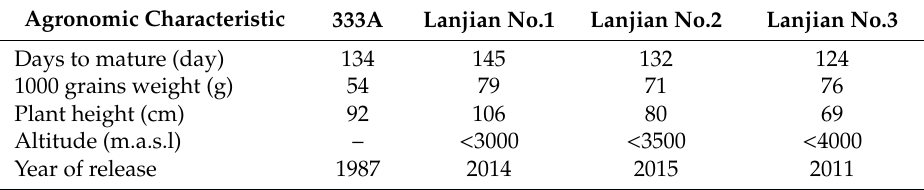
Source: Ministry of Agriculture, Beijing,